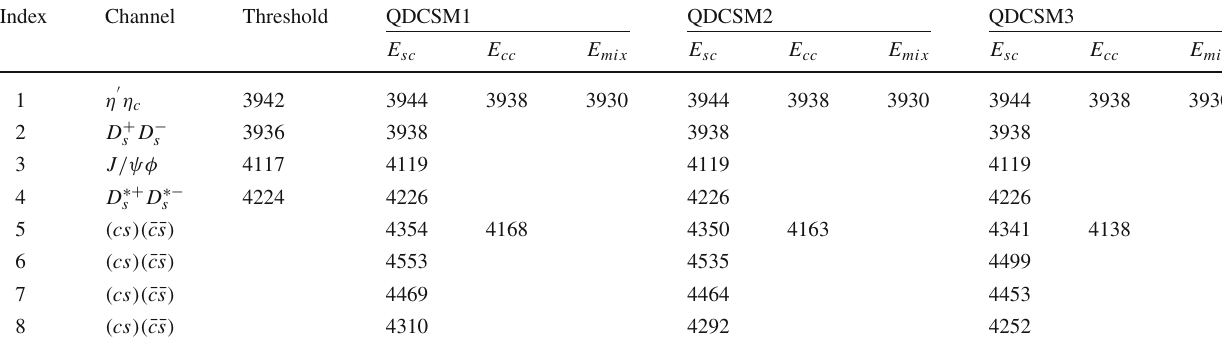
Table 4 The lowest-lying eigenenergies (in MeV) of c ¯ cs ¯ s tetraquarks with J PC = 0 ++